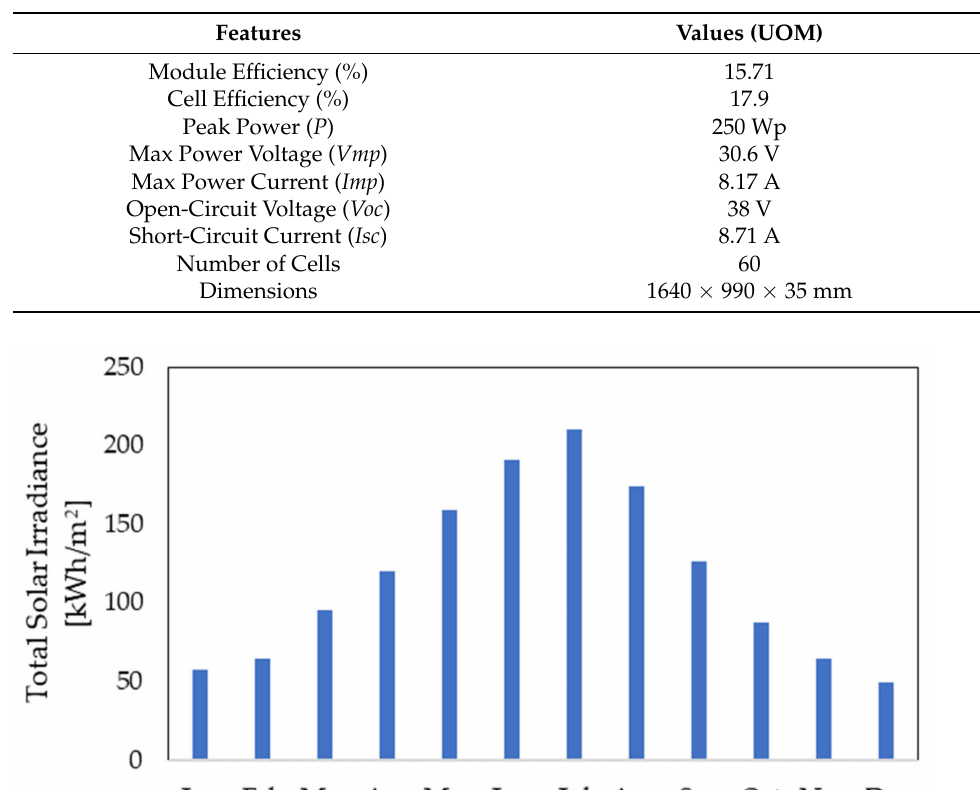
Table 3. PV module (polycrystalline cells) specifications.